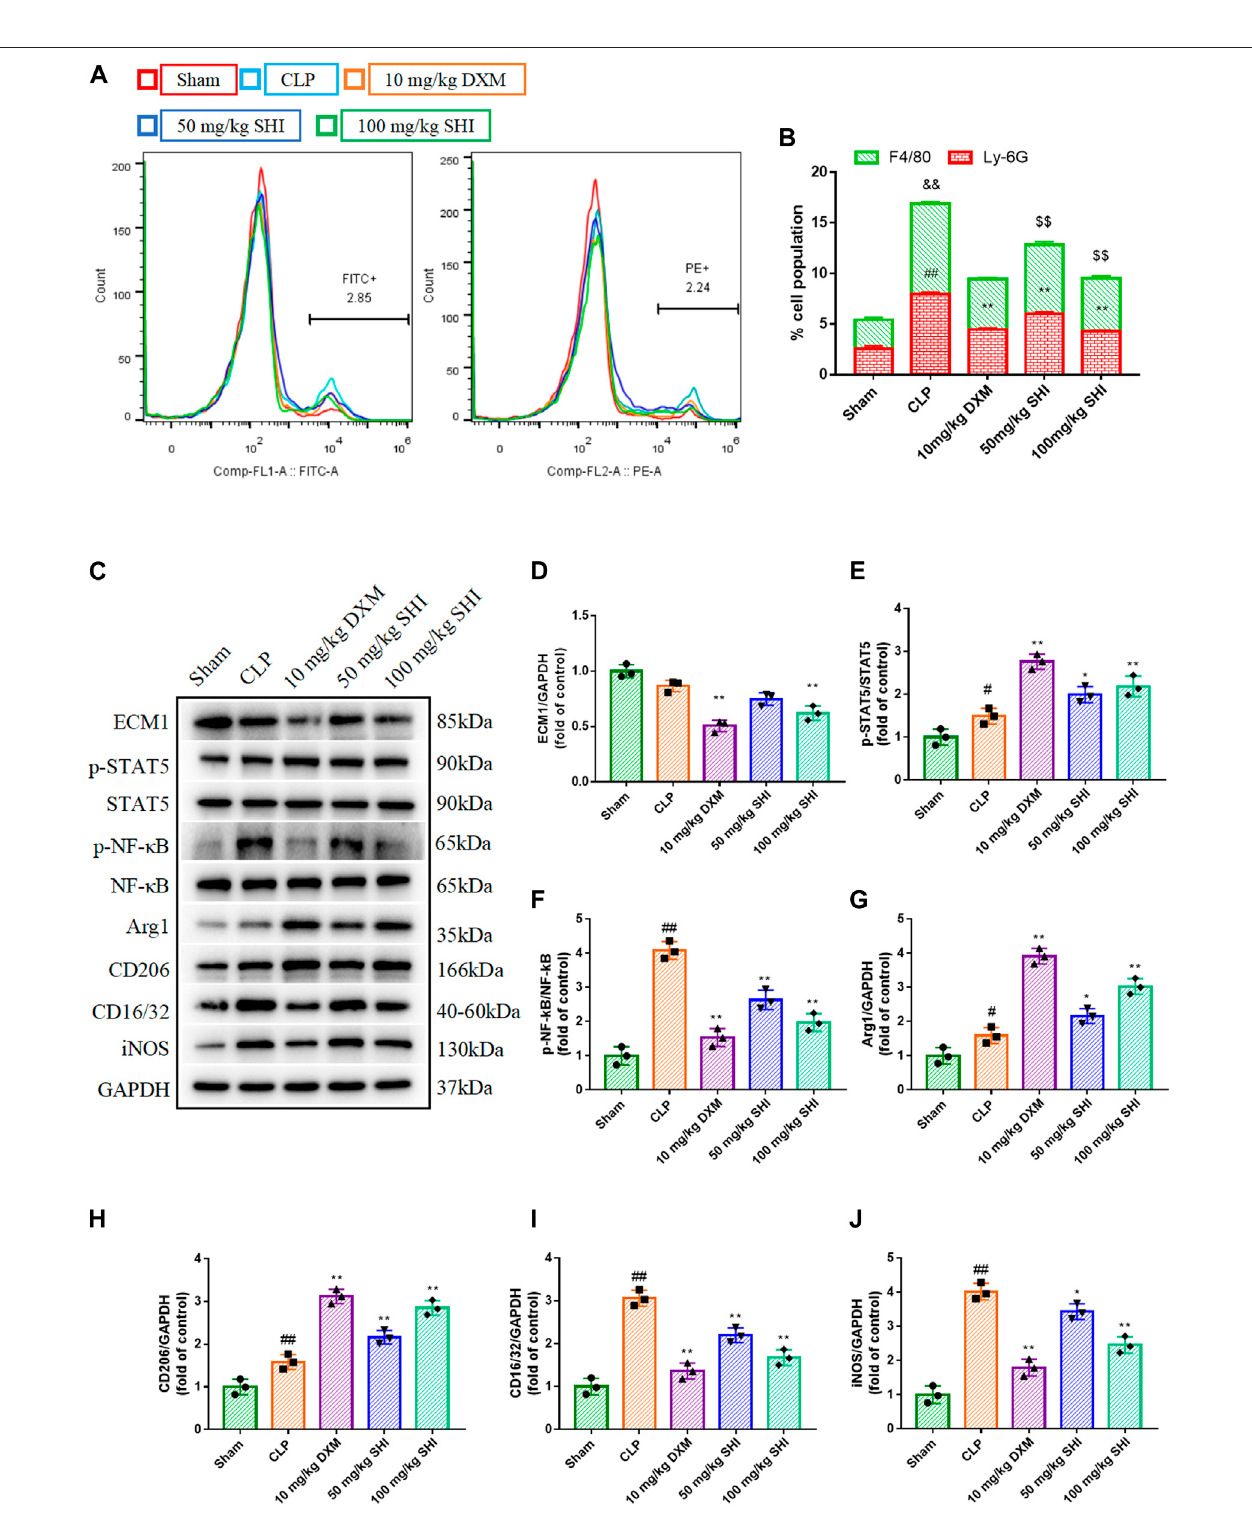
FIGURE2| TheeffectofSHI onECM1/STAT5/NF- κ Bsignaling inCLP-inducedmice.Themicewereintragastricallytreatedwithdrugs2 hbeforethesurgery,and at0,2,12 haftertheCLPsurgery,respectively.Theneutrophilswerestainedbyanti-Ly6G-PE,whilethemacrophageswerestainedbyanti-F4/80-FITC. (A,B) Theeffect of SHI on the populations of neutrophils and macrophages in the BALF were detected by fl ow cytometry. (C – J) The protein expressions of ECM1, p-STAT5, STAT5, p-NF- κ B, NF- κ B, Arg1, CD206, CD16/32, and iNOS in lung tissues. The data are expressed as mean ± SD. Compared with sham: # p < 0.05, ## p < 0.01. Compared with CLP: * p < 0.05, ** p < 0.01.